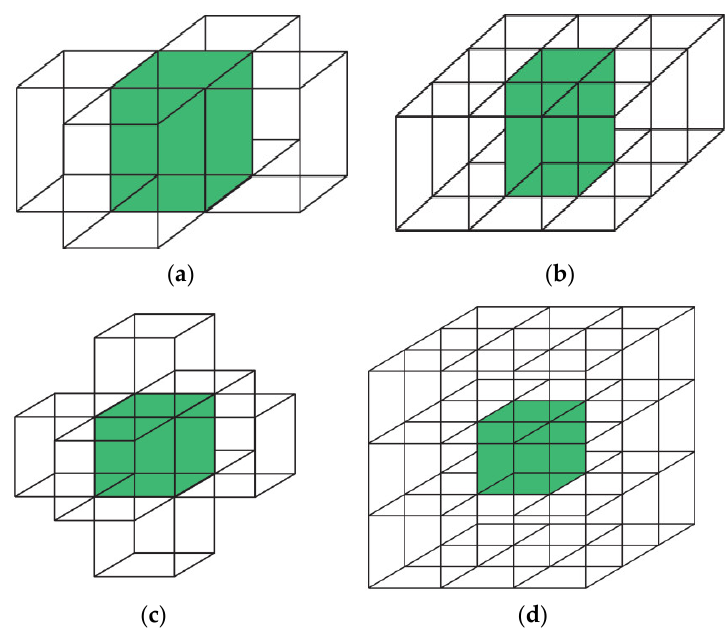
Figure 3. Four kinds of neighborhood diagrams. ( a ) Plane four neighborhoods; ( b ) plane eight neighborhoods; ( c ) stereo six neighborhoods; ( d ) stereo twenty-six neighborhoods.